Question: In one sentence, what is this figure communicating?
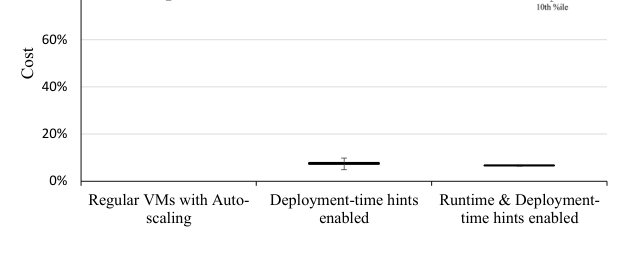
Answer: Slowdown and cost running the Big Data workload. The baseline (i.e., 1×, 100%) is the median for Regular VMs.